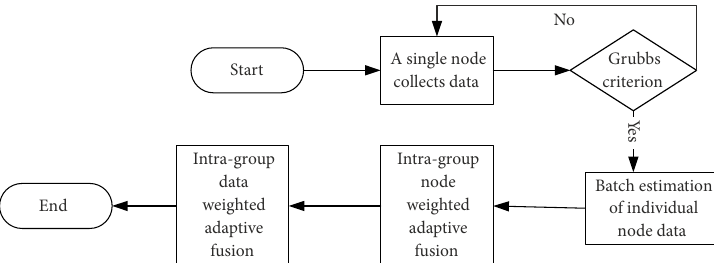
Figure 3. Flowchart of the proposed